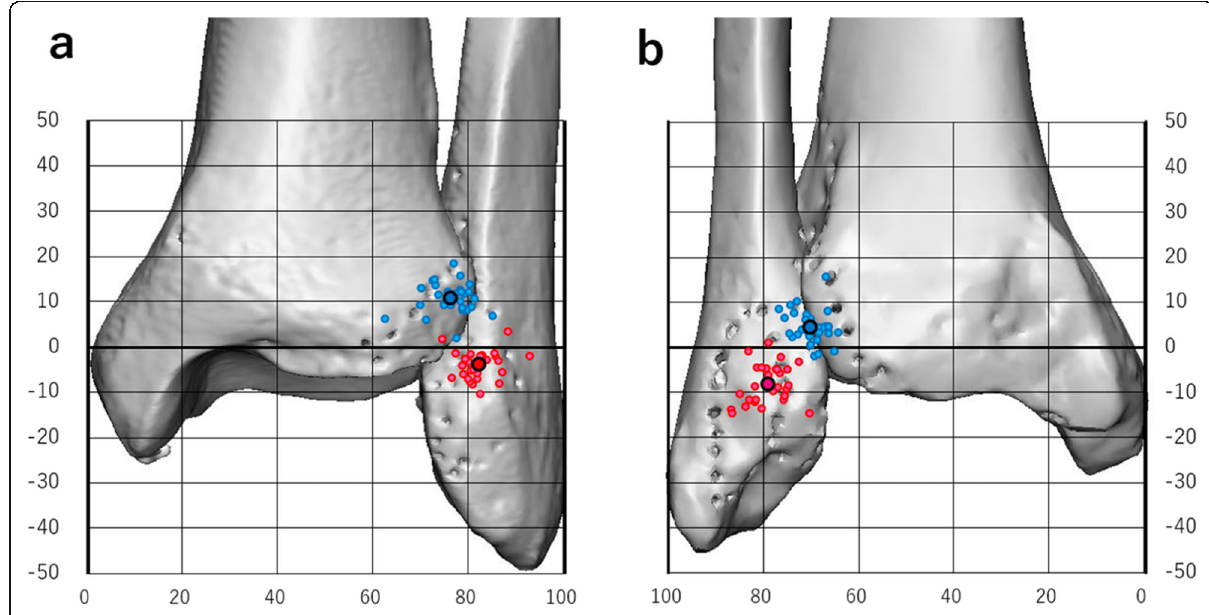
Fig. 4 Coordinate maps of the insertions of the ligaments. Coordinates for the centers of the tibial (blue circles) and fibular (red circles) insertion sites of the ( a ) anterior inferior tibiofibular ligament and ( b ) posterior inferior tibiofibular ligament The large blue circle and red circle indicate the mean centers of the insertion sites of these